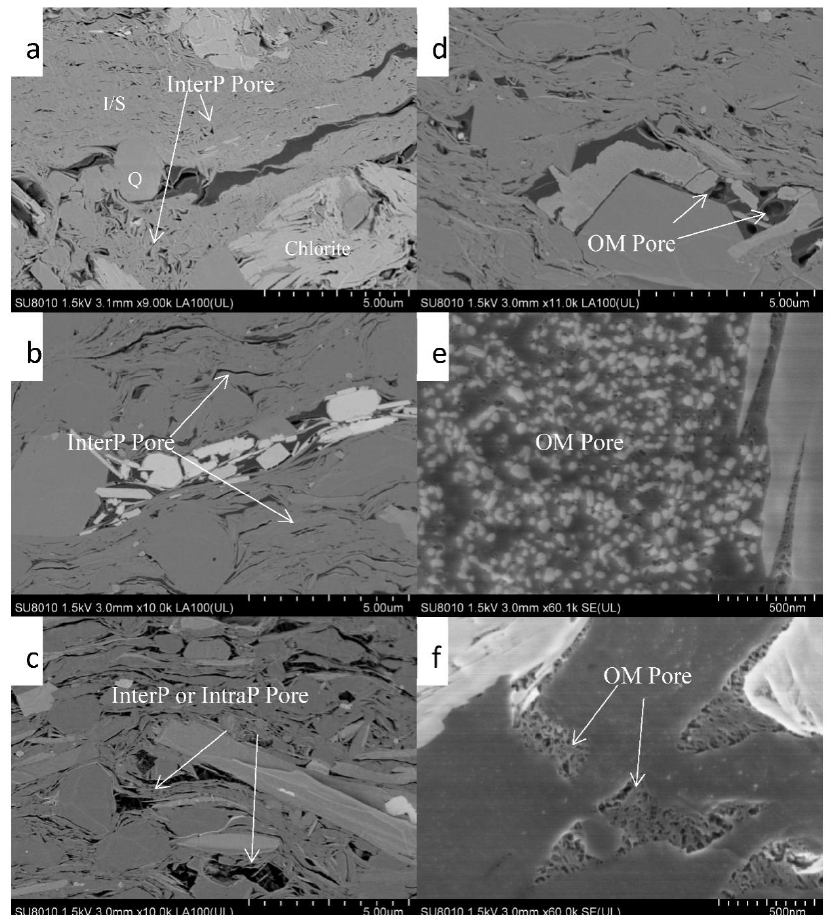
Figure 3. FE-SEM images of various types of pores. ( a ) Sample QP-2; ( b ) Sample X83-6; ( c ) Sample YX58-10; ( d ) Sample Z42-2; ( e ) Sample Y47-5; ( f ) SampleY47-5.